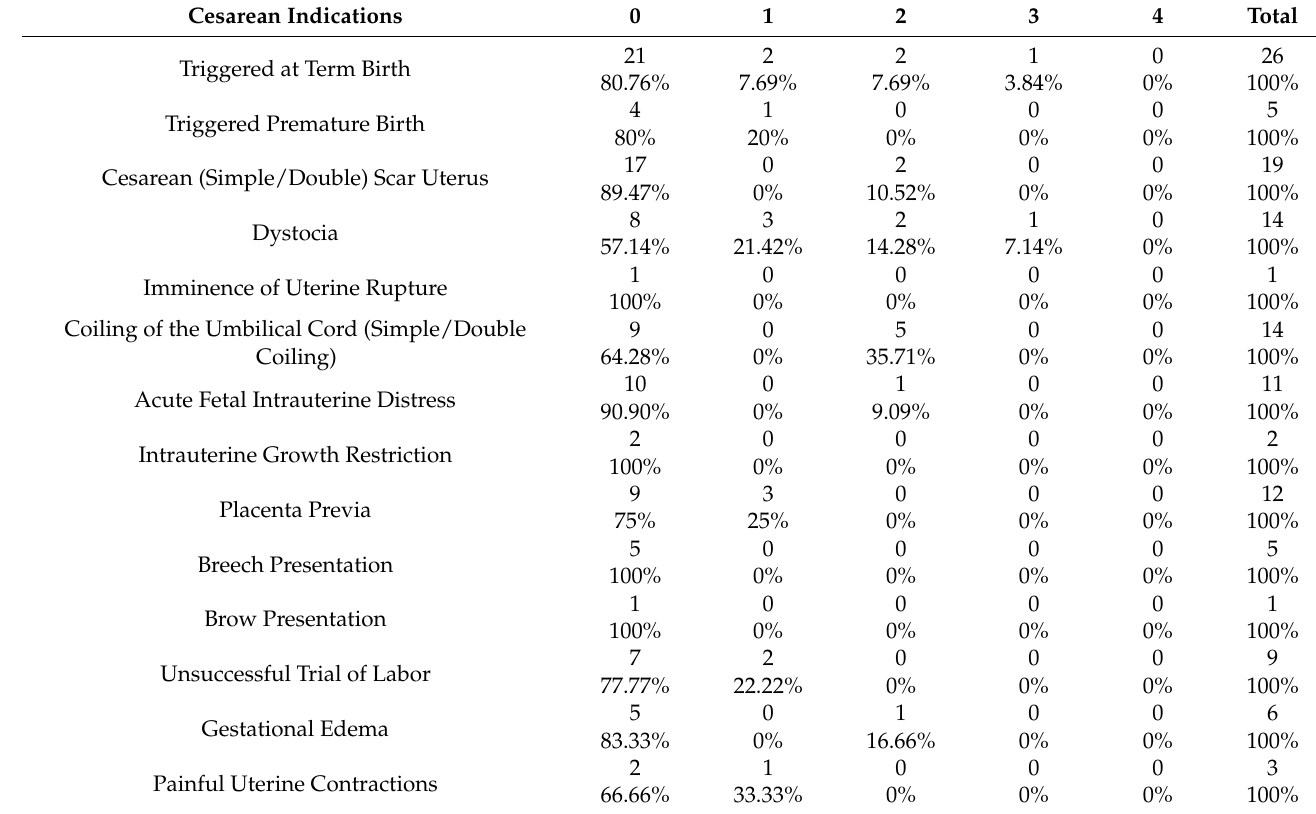
Table 5. Conditions that, single or associated, necessitated a cesarean section in the patients studied and the PUUS values for each